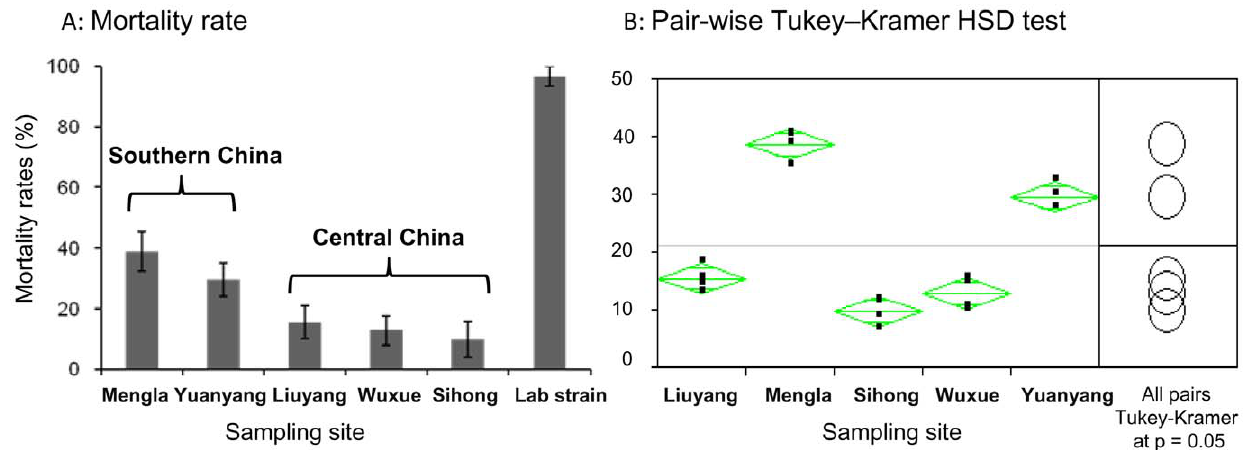
Figure 2. Mortality rates of Anophelessinensis in standard WHO tube bioassays. A: after exposure to 0.05% deltamethrin test papers and 24 hr recovery period. B: pairwise Tukey–Kramer HSD test for statistical significance in mortality rates. The vertical bar stands for standard error of the mean.